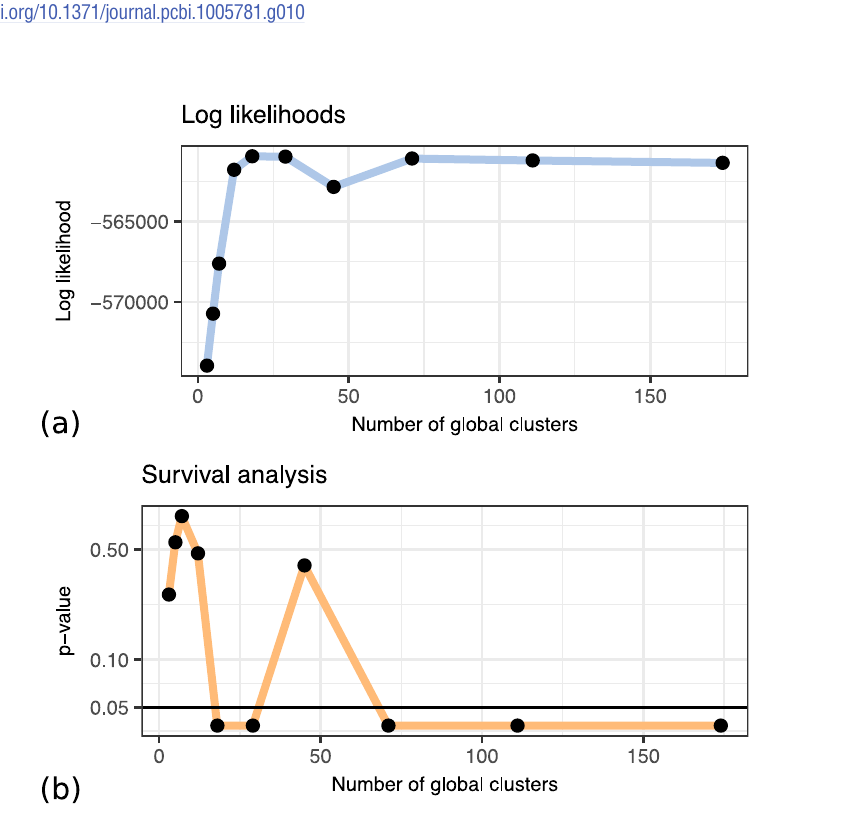
Fig 11. Log likelihoods (a) and survival p -values (b) of models with different numbers of global clusters. The first significantdifference in survival corresponds to the model with the highestlog likelihood.